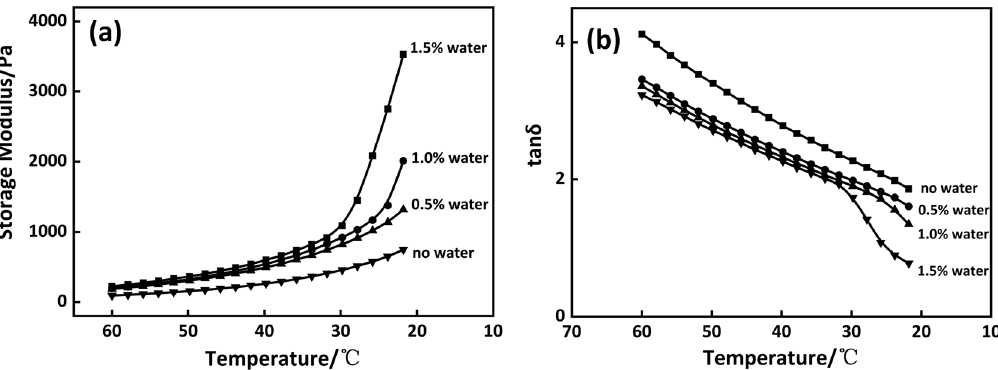
Figure 3: Temperature dependence of ( a ) G ′ and ( b ) tan δ of PAN solution with di ff erent water